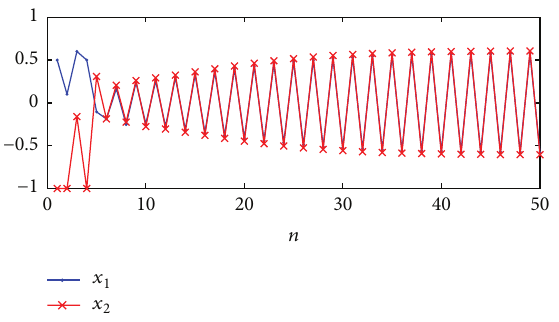
Figure 1: The response curves of system (36) without impulsive effects.